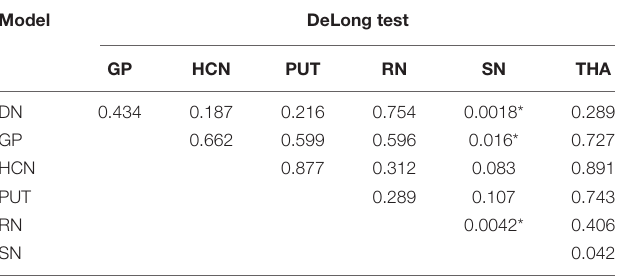
TABLE 3 | The DeLong test for the model comparisons.